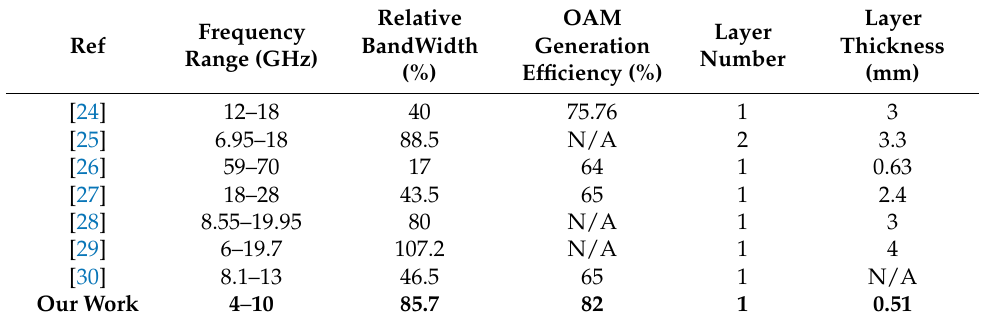
Table 3. Comparison of broadband OAM generation schemes in